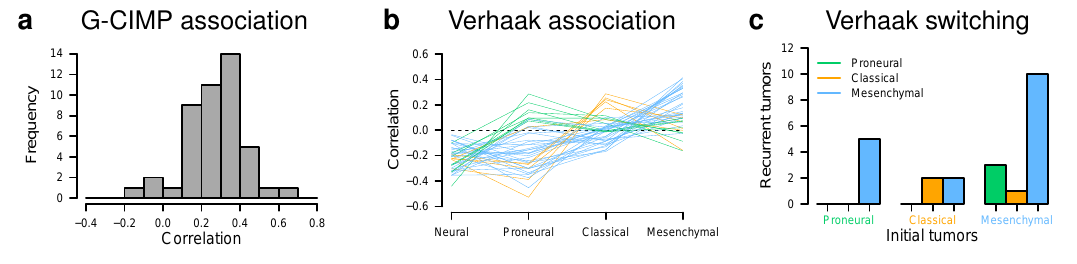
Figure 4. Associations of tumor expression profiles with G-CIMP and Verhaak subtypes. ( a ) Pearson correlations of tumor gene expression profiles with the corresponding genes in the G-CIMP reference set. Tumors with positive correlations are G-CIMP positive and tumors with negative correlations are G-CIMP negative; ( b ) Pearson correlations of tumor gene expression profiles with the